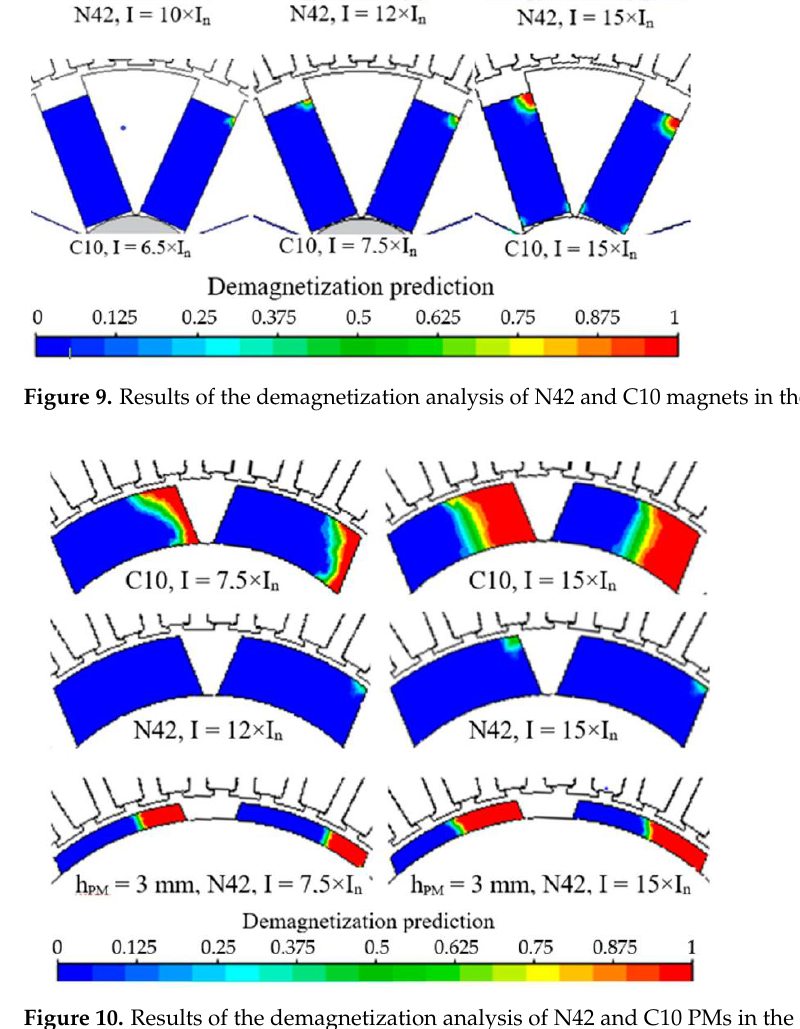
Figure 10. Results of the demagnetization analysis of N42 and C10 PMs in the radial machine.